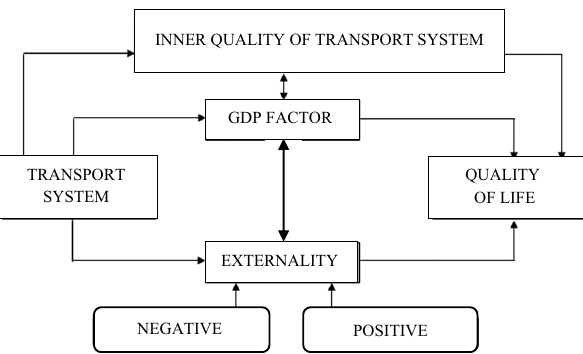
Figure 1: Transport system and quality of